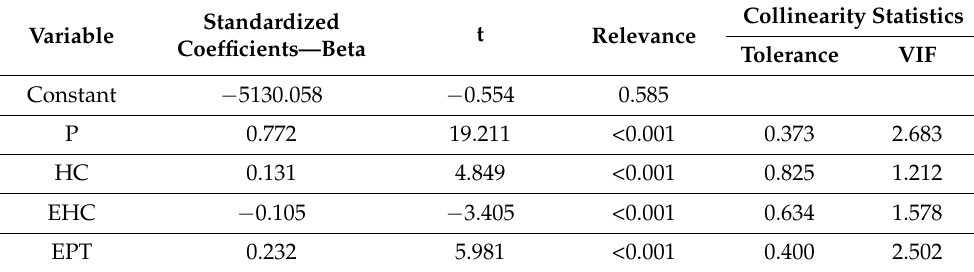
Table 7. Coefficients in the regression model of greenhouse gas emissions in 2018.